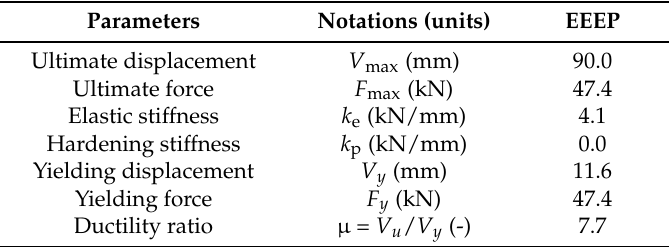
Table 2. Wall B test results and interpretation according to equivalent Elastic–Plastic Energy method (EEEP)